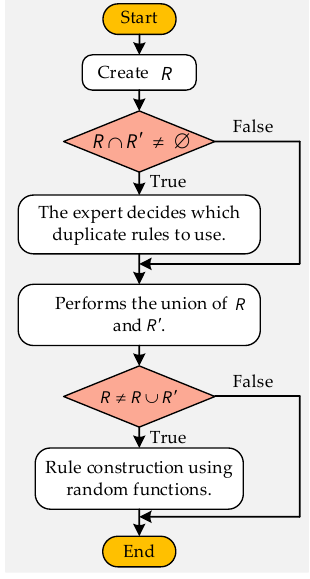
Figure 7. Rule supplement